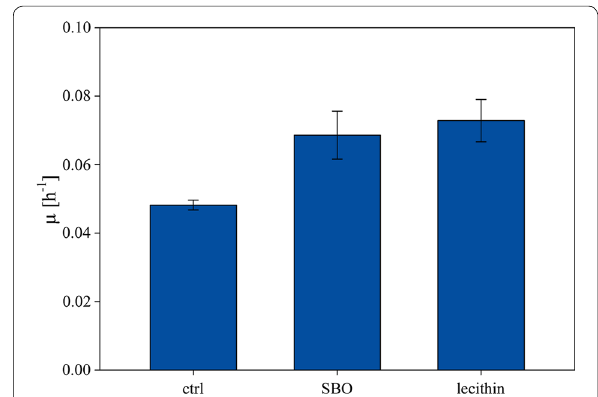
Fig. 4 Shake flask experiments with a P. chrysogenum strain and different media supplementation. Media were either not supplemented or supplemented with crude SBO or an equivalent amount of extracted lecithin